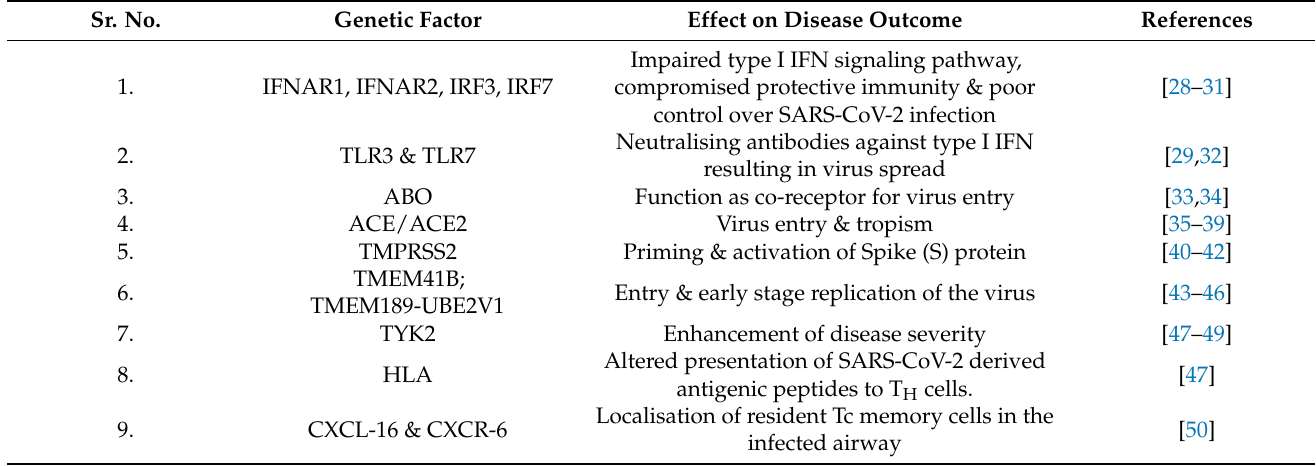
Table 1. Genetic factors influencing the